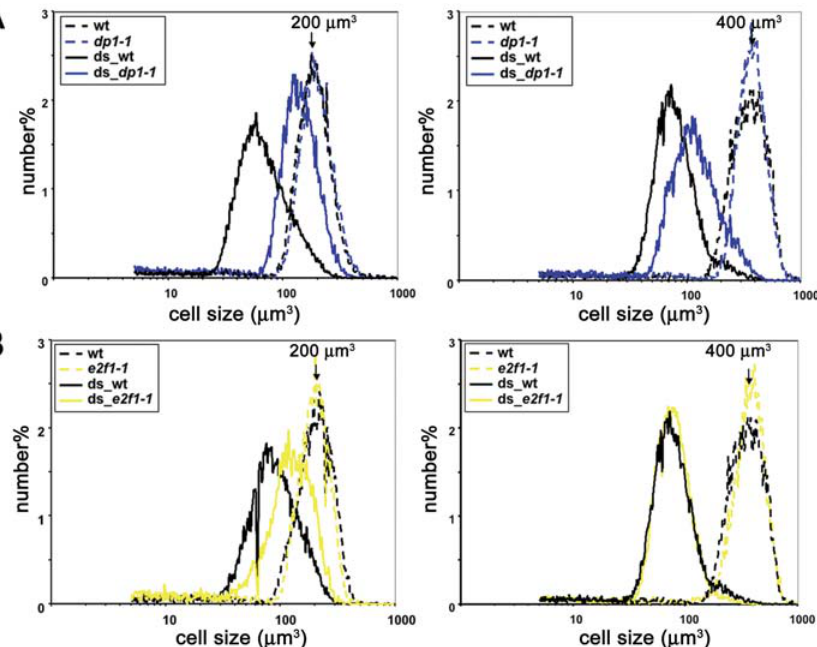
Figure 4. Commitment Experiments with Synchronized Wild-Type, dp1–1, and e2f1–1 (A) Size distributions of synchronized cells growing in the light (dashed lines) and after dark-shifting (ds) (solid lines) for wild-type (black lines) and dp1– 1 (blue lines) cultures at two different times during G1 (left and right panels). In the left panel, the preshifted cells have a modal size of approximately 200 l m 3 , and in the right panel, they have a modal size of approximately 400 l m 3 . (B) Size distributions of synchronized cells growing in the light (dashed lines) and after dark-shifting (ds) (solid lines) for wild-type (black lines) and e2f1– 1 (yellow lines) cultures at two different times during G1 (left and right panels). In the left panel, the preshifted cells have a modal size of approximately 200 l m 3 , and on the right panel, they have a modal size of approximately 400 l m 3 . DOI: